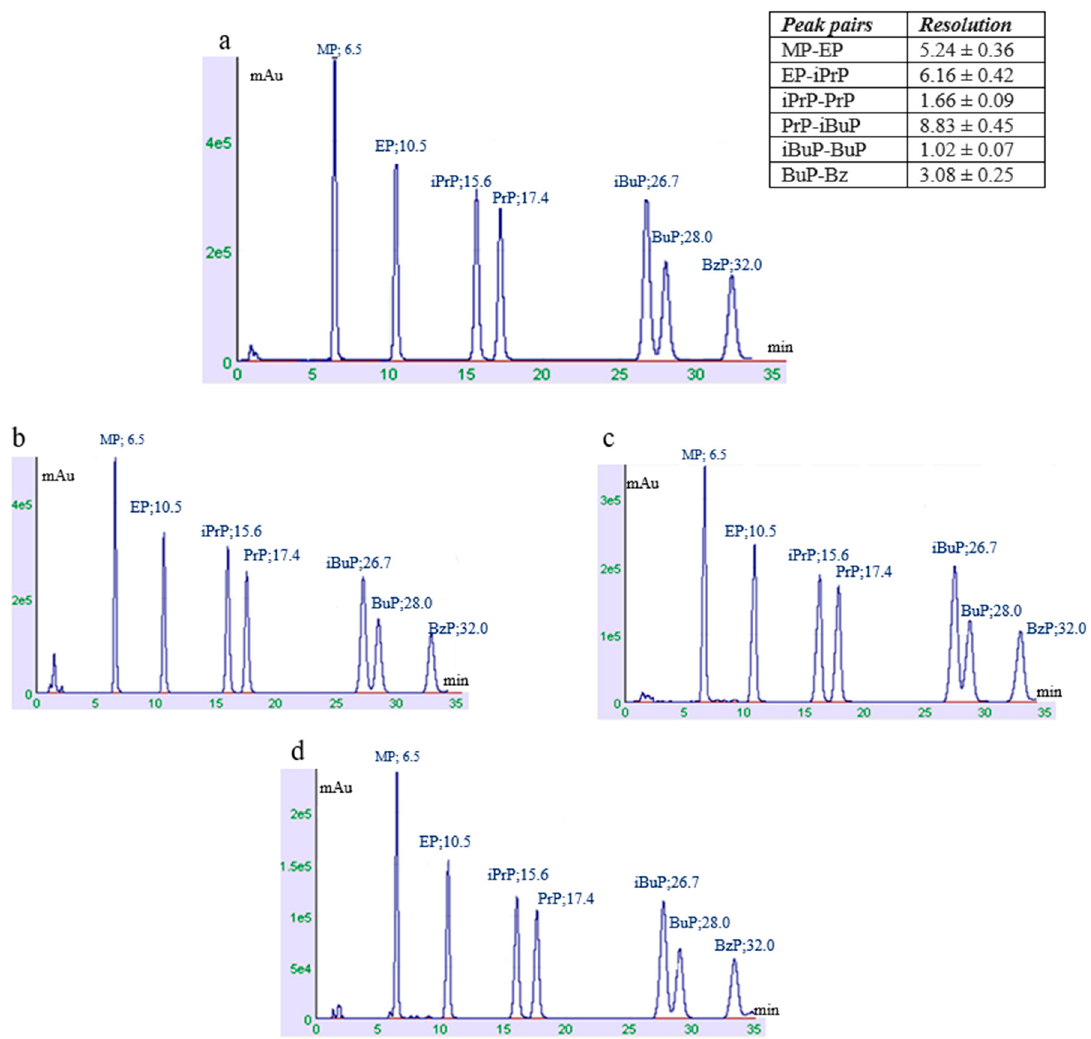
Figure 1. Chromatograms obtained for a standard mixture of the Parabens in ethanol ( a ) and of a 50 μ g mL − 1 extracted from Stratum Corneum ( b ); Dermis ( c ); Epidermis ( d ).